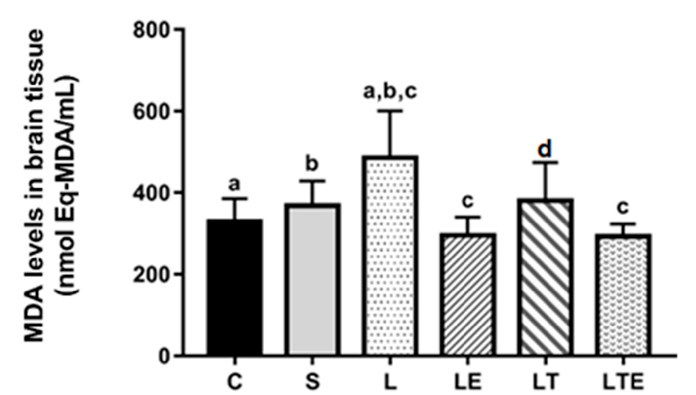
Figure 8. Analysis of MDA levels in the brain. Brain malondialdehyde levels (nmolEq-MDA / mL) after interventions in the di ff erent groups: C, control group; S, sham group; L, injury group; LE, injury + extract group; LT, injury + training group; LTE, injury + training + extract group. Values are expressed as mean ± standard deviation ( n = 10 in each group). The letters “a”, “b”, “c” and “d” when repeated indicate statistical di ff erences between the groups as determined by one-way ANOVA with Bonferroni post-hoc correction.